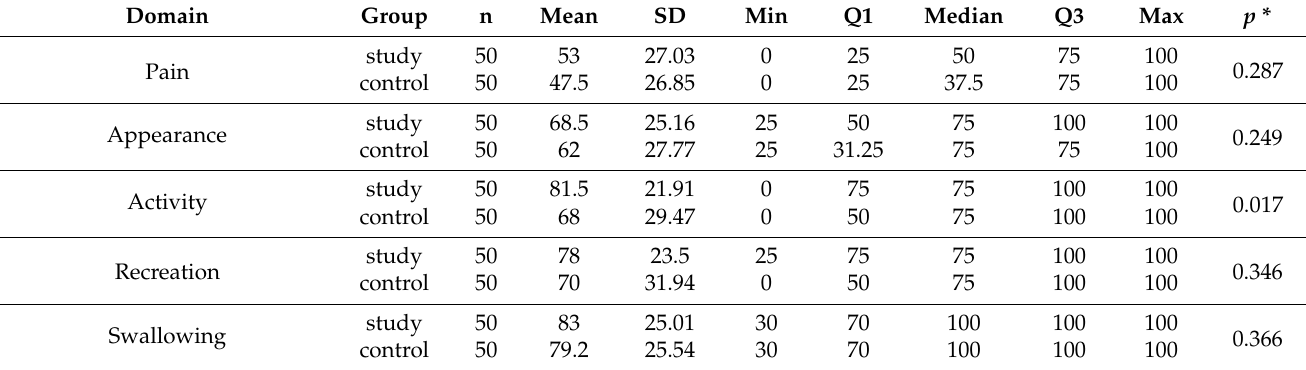
Table 6. The comparative analysis of QOL between the study groups during 7 postoperative